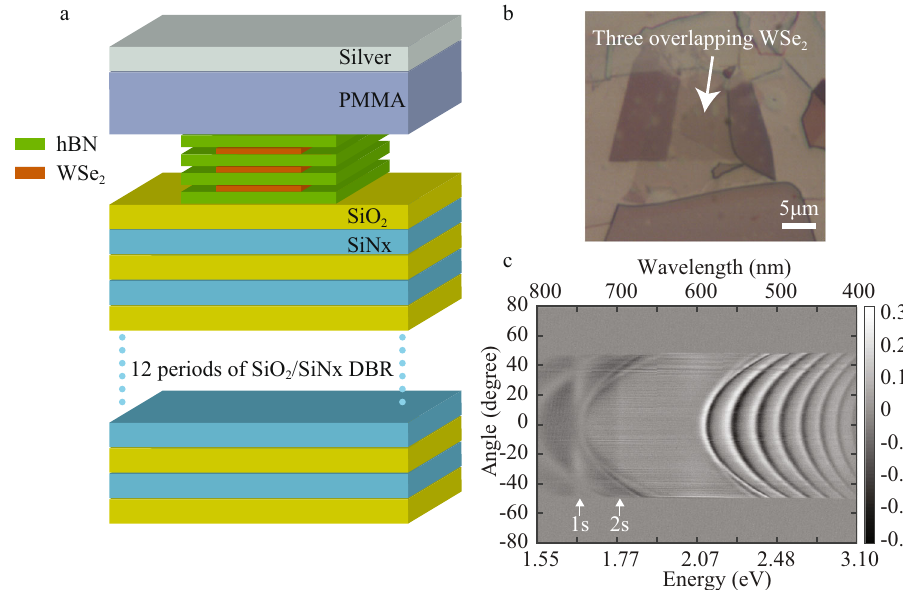
Fig. 1 Re fl ection spectrum of WSe 2 on DBR. a Schematic illustration of the sample structure. b Optical image after the multilayer hBN-WSe 2 stacking was transferred on top of the DBR. The area where three WSe 2 layers overlap is marked with the white arrow. c Angle resolved differential re fl ection of multilayer structure on DBR at room temperature. Absorption features can be observed at the energies of the 1 s and 2 s exciton and are marked by the white